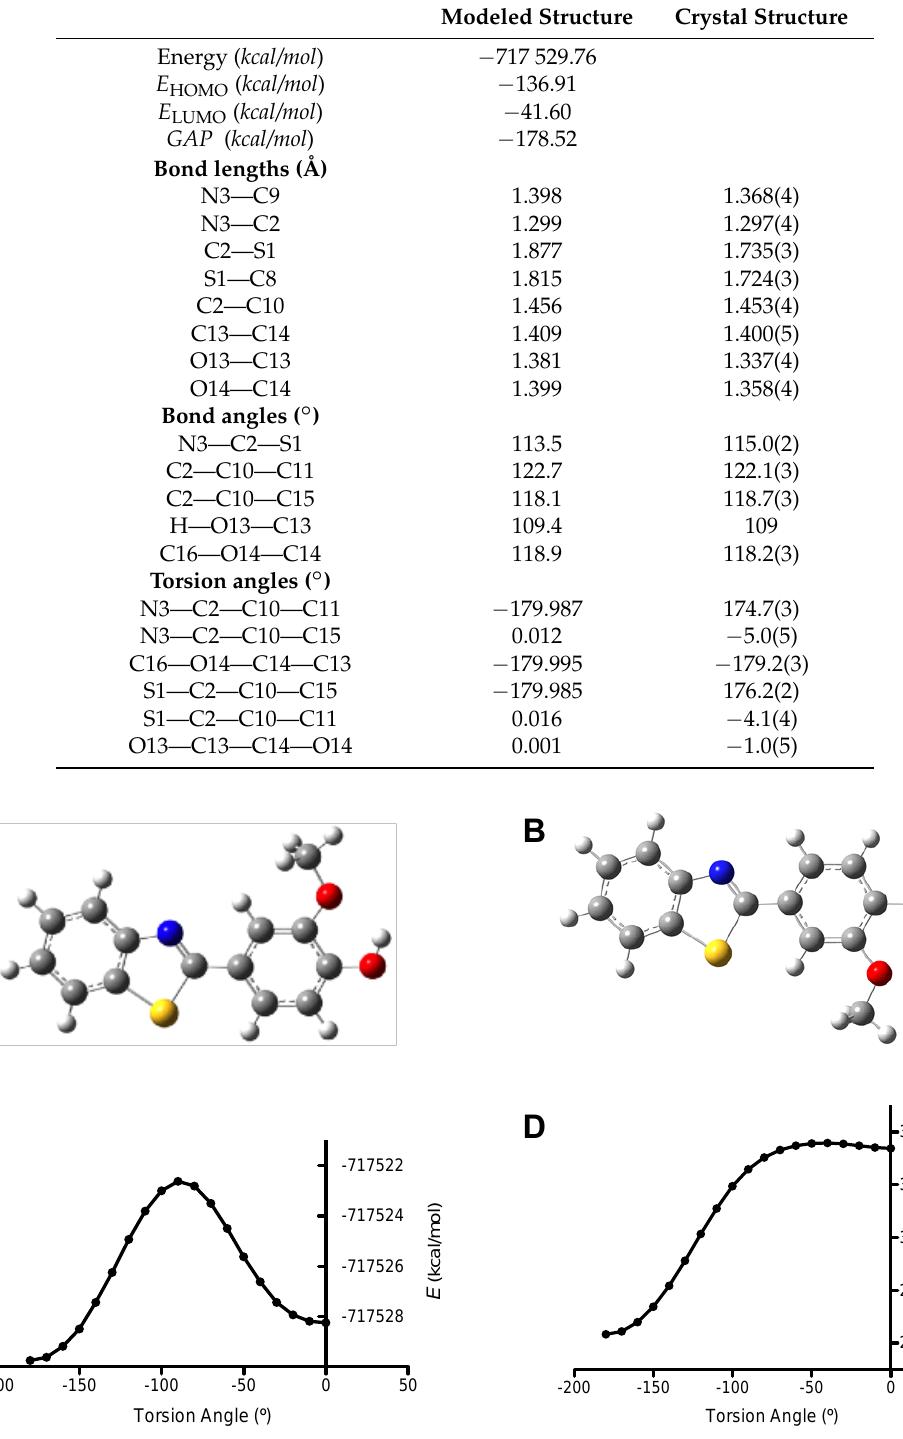
Comparison between modeled and crystal geometric structures of 2-(4-hydroxy-3- methoxyphenyl)-benzothiazole.